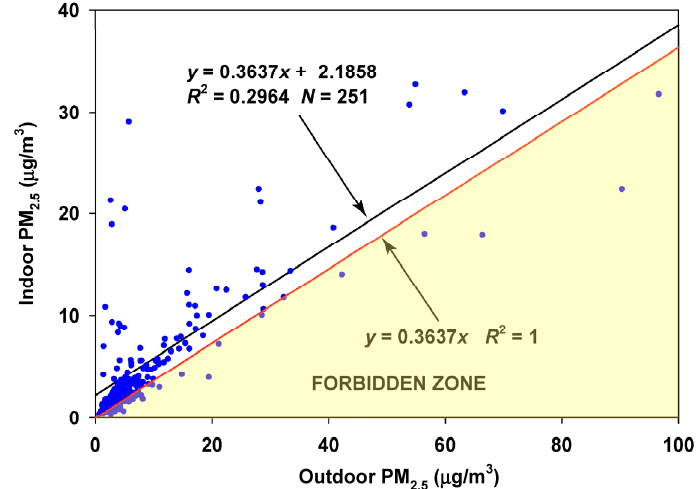
Figure 14. Regression of Oakmont indoor concentrations on Bennett Valley outdoor concentrations for the summer and fall months